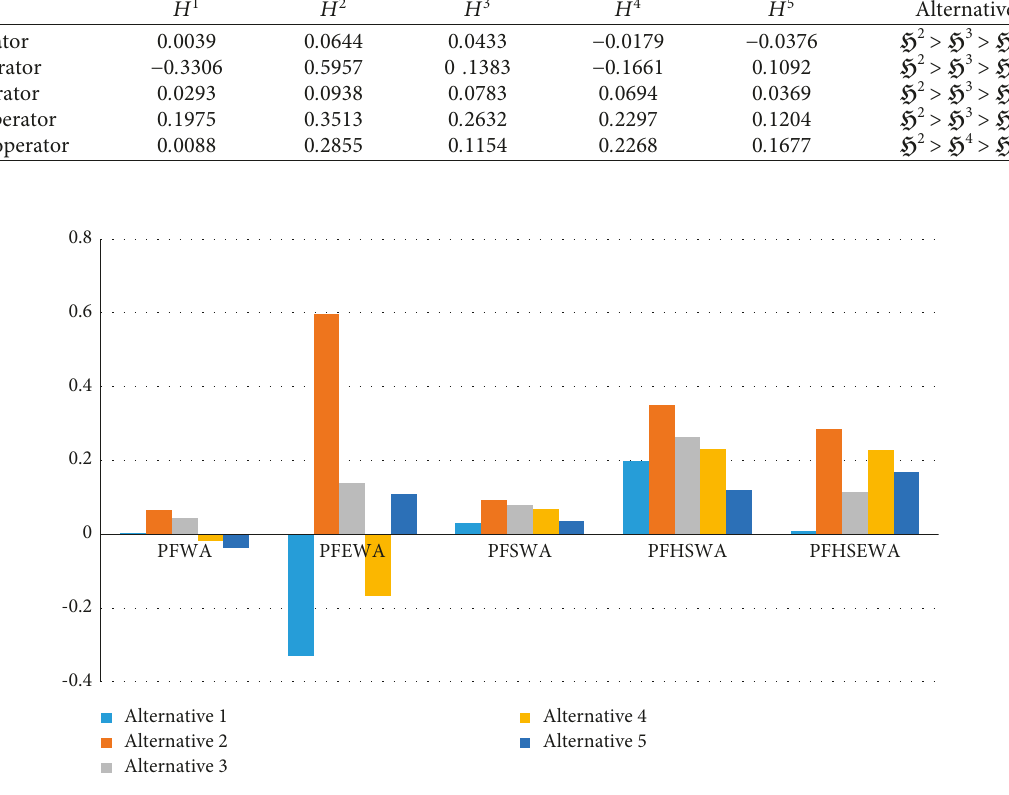
Figure 2: Graphical results of comparative